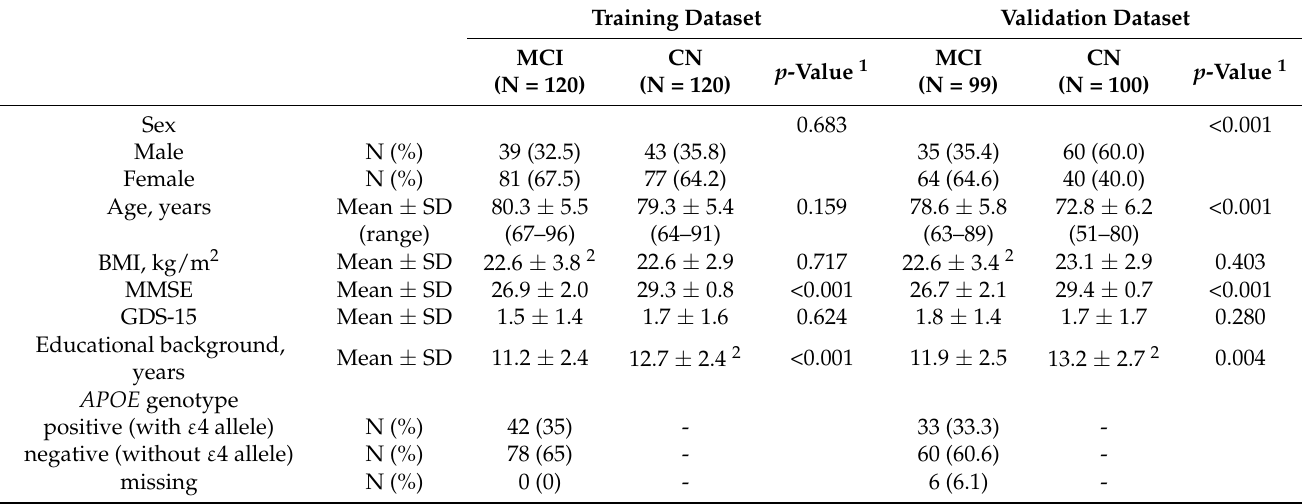
Table 1. Characteristics of MCI and CN